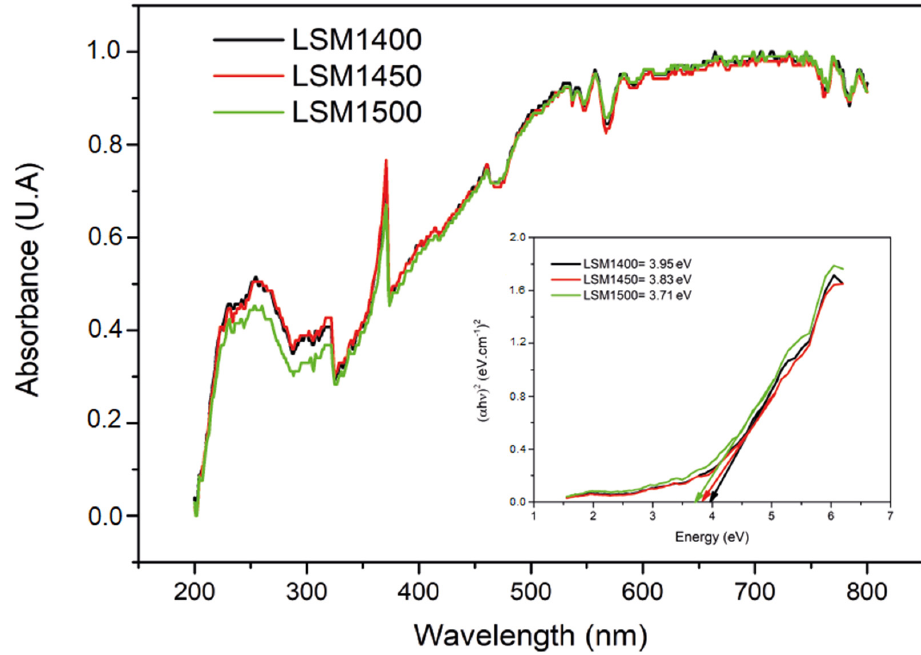
Figure 4. Optical absorbance and band gap spectra of the La 0.6 Sr 0.4 MnO 3 samples calcined at different temperatures (1400, 1450, or 1500 °C).